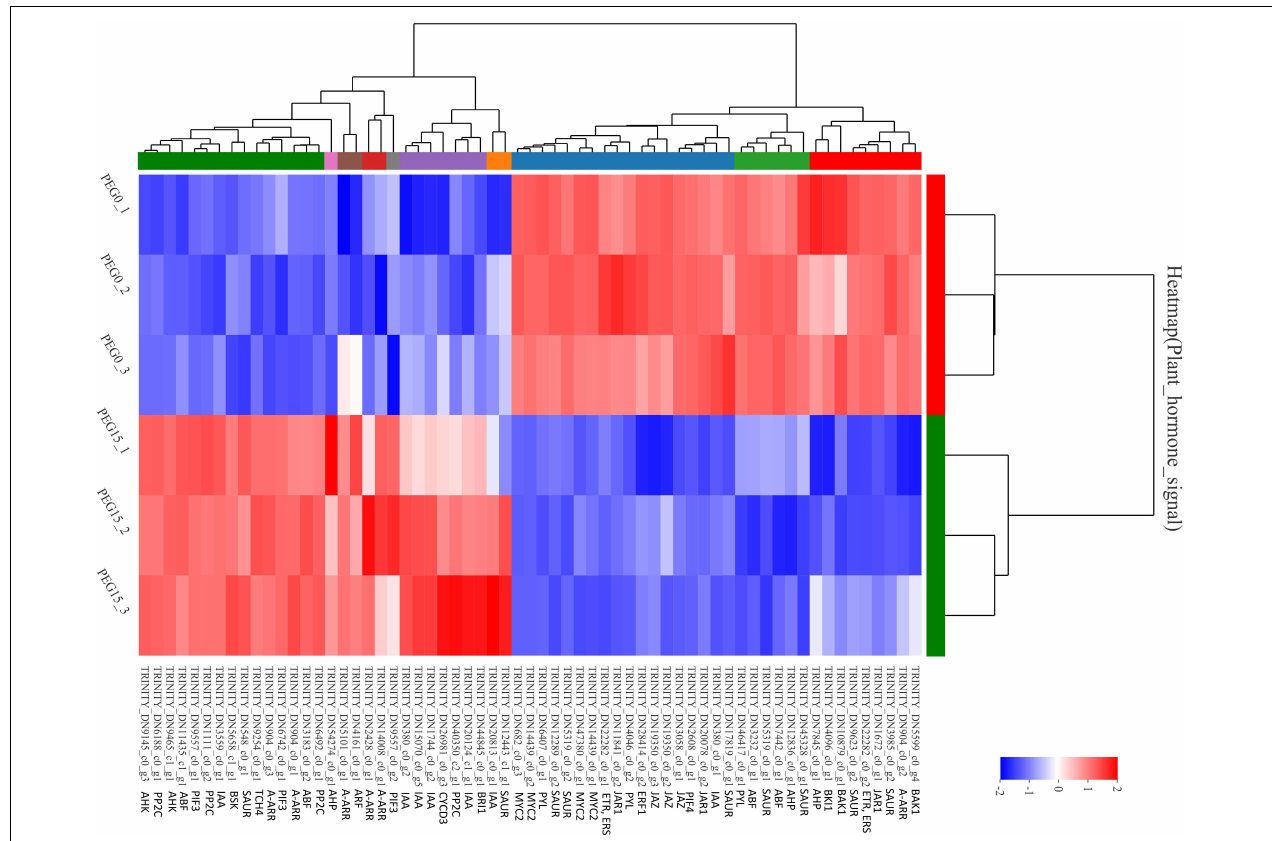
FIGURE 9 | The heat map of the DEGs involved in the “plant hormone signal transduction”